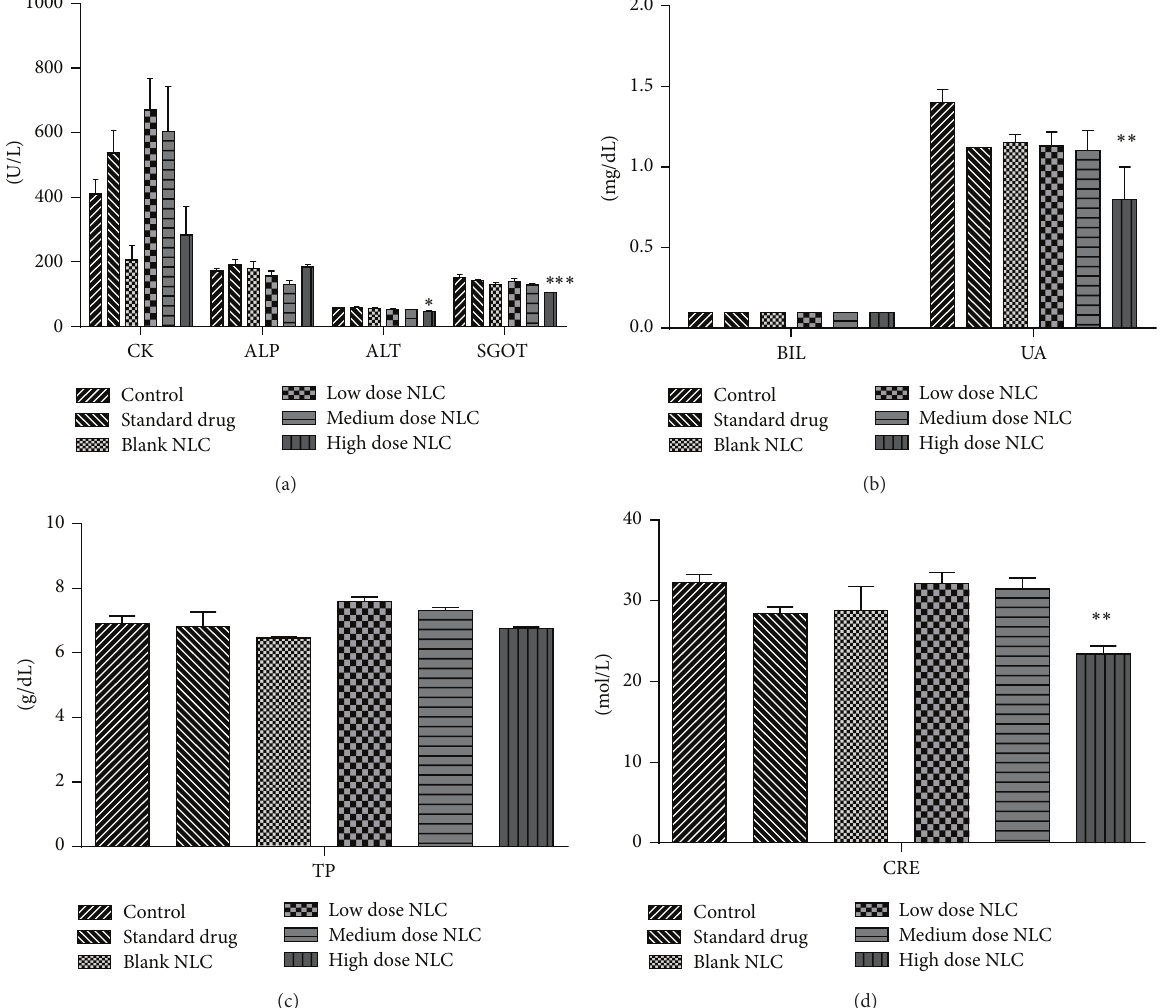
Figure 6: (a, b, c, and d) Clinical parameters of male rats treated with NLCs formulation. All the values are represented as mean ± SEM and 𝑛 = 5 . ∗ 𝑝 < 0.05 , ∗∗ 𝑝 < 0.01 , and ∗∗∗ 𝑝 < 0.001